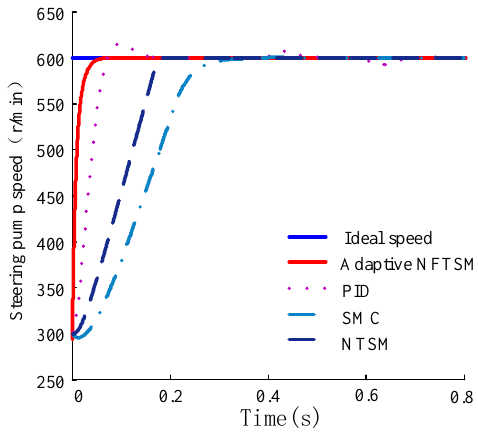
Figure 15. Speed response when load torque is changed.